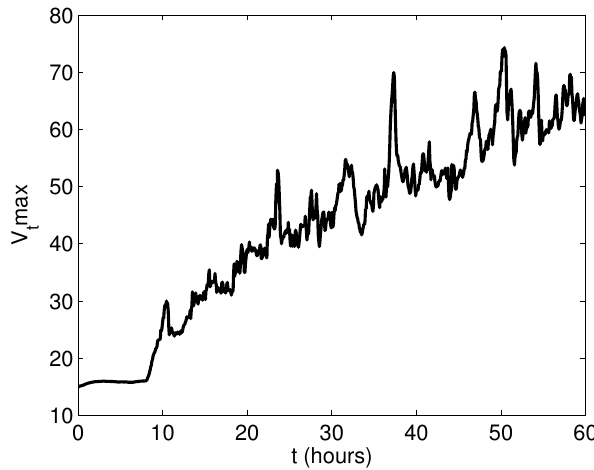
Fig. 1. Intensification of the simulated vortex is shown by the local maximum of horizontal wind speed V t,max as a function of time from t=0 to t=60 hours.